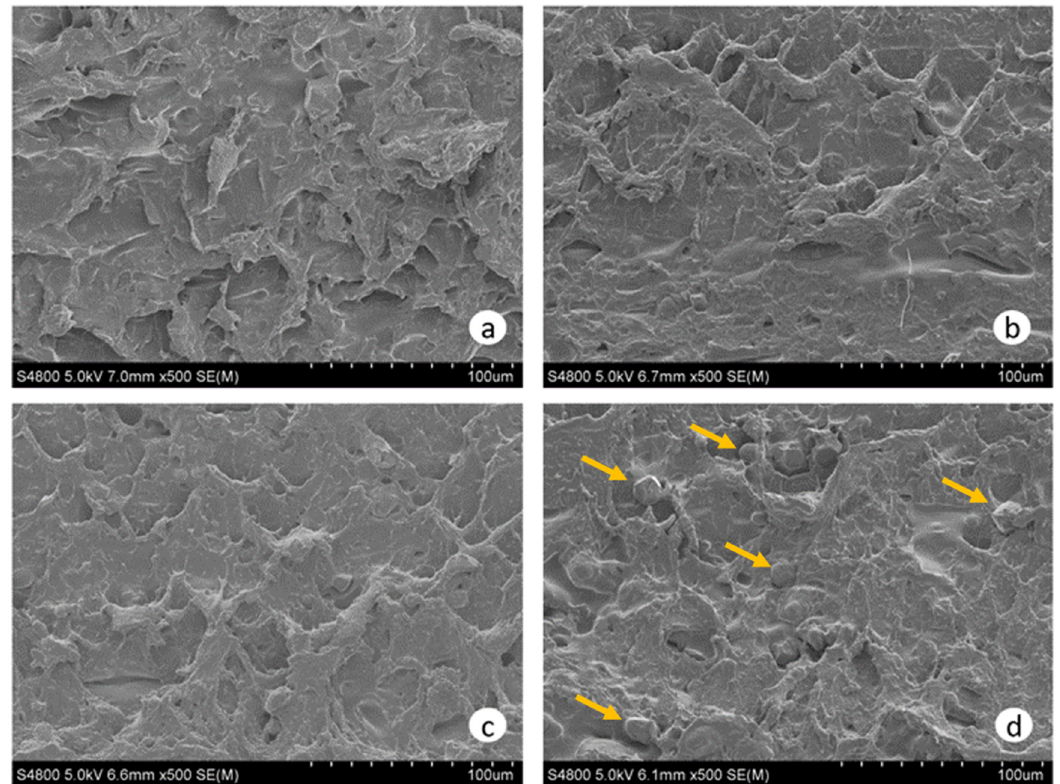
Figure 6. SEM images of WPI films as a function of ascorbic acid (AA) content: ( a ) 0 (Control), ( b ) 5, ( c ) 10, and ( d ) 15 wt% AA. Yellow arrows point out small granules observed in WPI films.